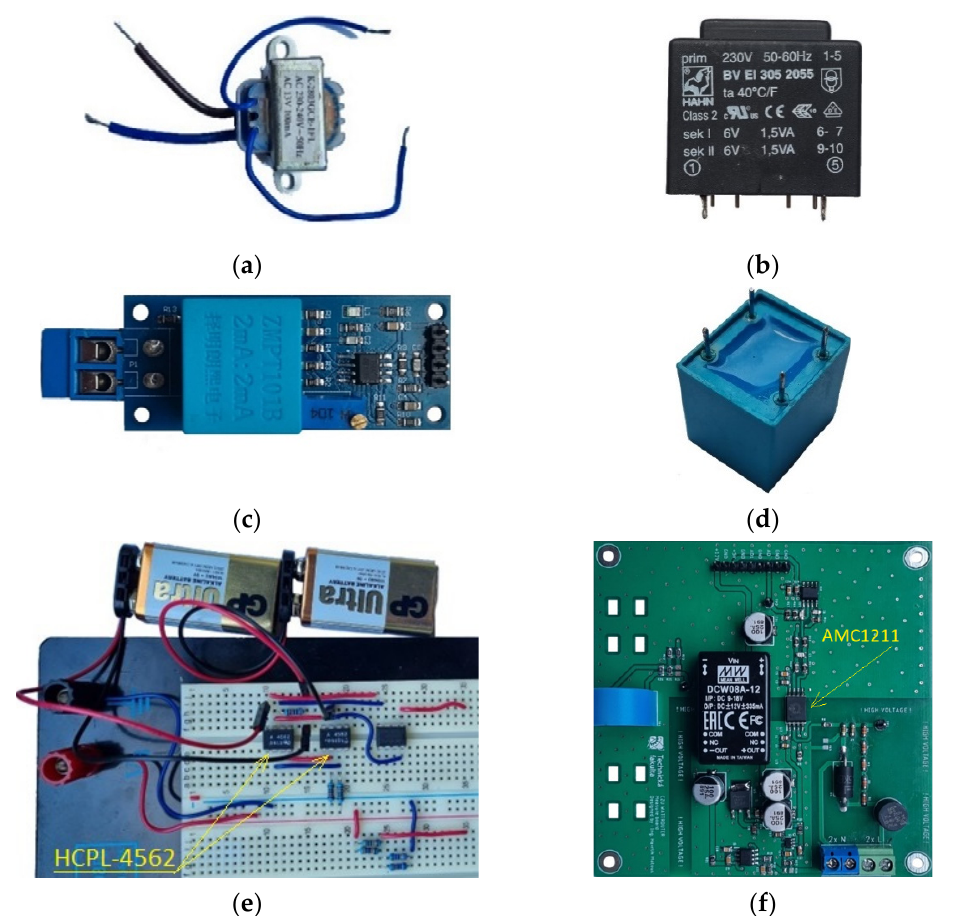
Figure 1. ( a ) K-2803GCE-1FL transformer, ( b ) BV EI 305 2055 HAHN transformer, ( c ) ZMPT101B single-phase AC voltage sensor, ( d ) Stand-alone current transformer ZMPT101B, ( e ) The fixture with the optocouplers HCPL-4562, ( f ) The fixture with an AMC1211 circuit.